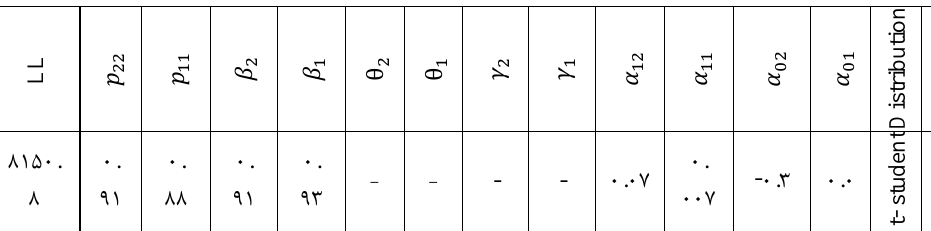
Table 9. MRS–GARCH models of the chemical